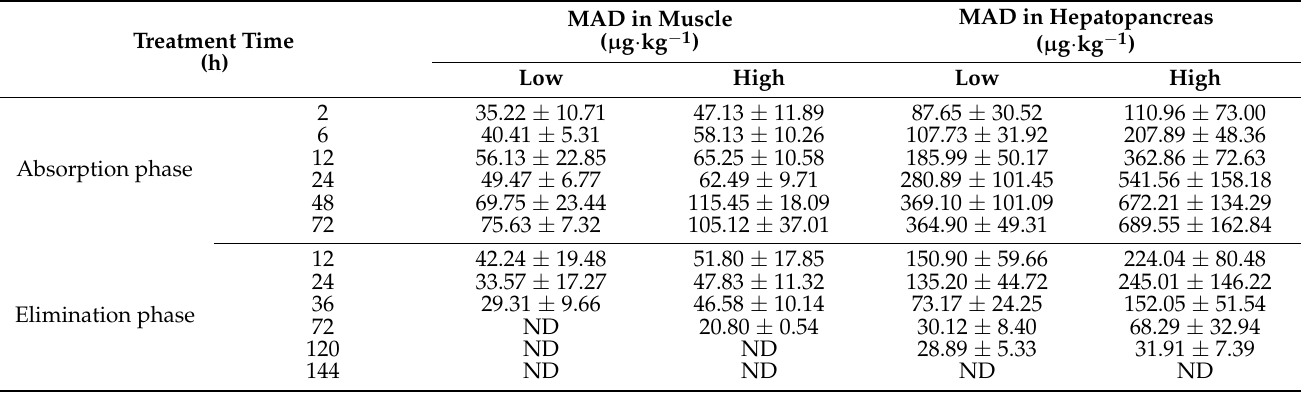
Table 2. Residue and elimination characteristics of maduramicin (MAD) in abdominal muscle and hepatopancreas tissues of crayfish ( n =